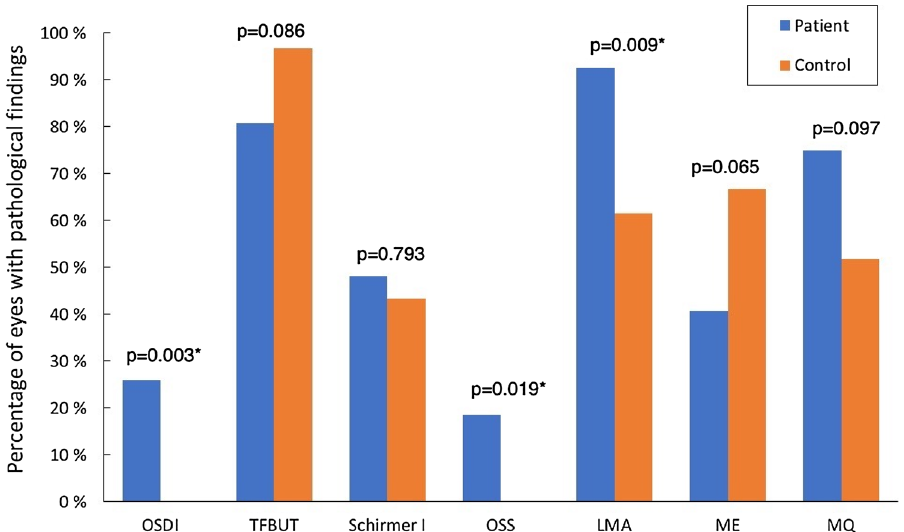
Figure 3. Percentage of abnormal results of the dry eye diagnostic tests obtained in patient and control groups. OSDI Ocular Surface Disease Index questionnaire, TFBUT tear film break-up time, OSS ocular surface staining, LMA lid margin abnormality, ME meibomian gland expressibility, MQ meibum quality. *Statistically significant inter-group differences using the χ 2